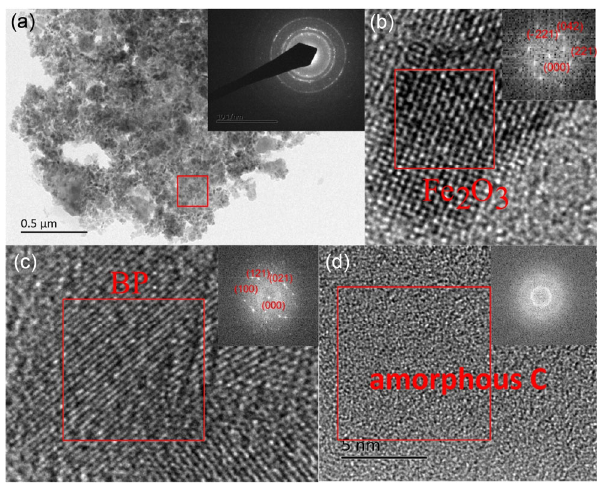
Fig. 25 TEM and HRTEM images of the wear debris.